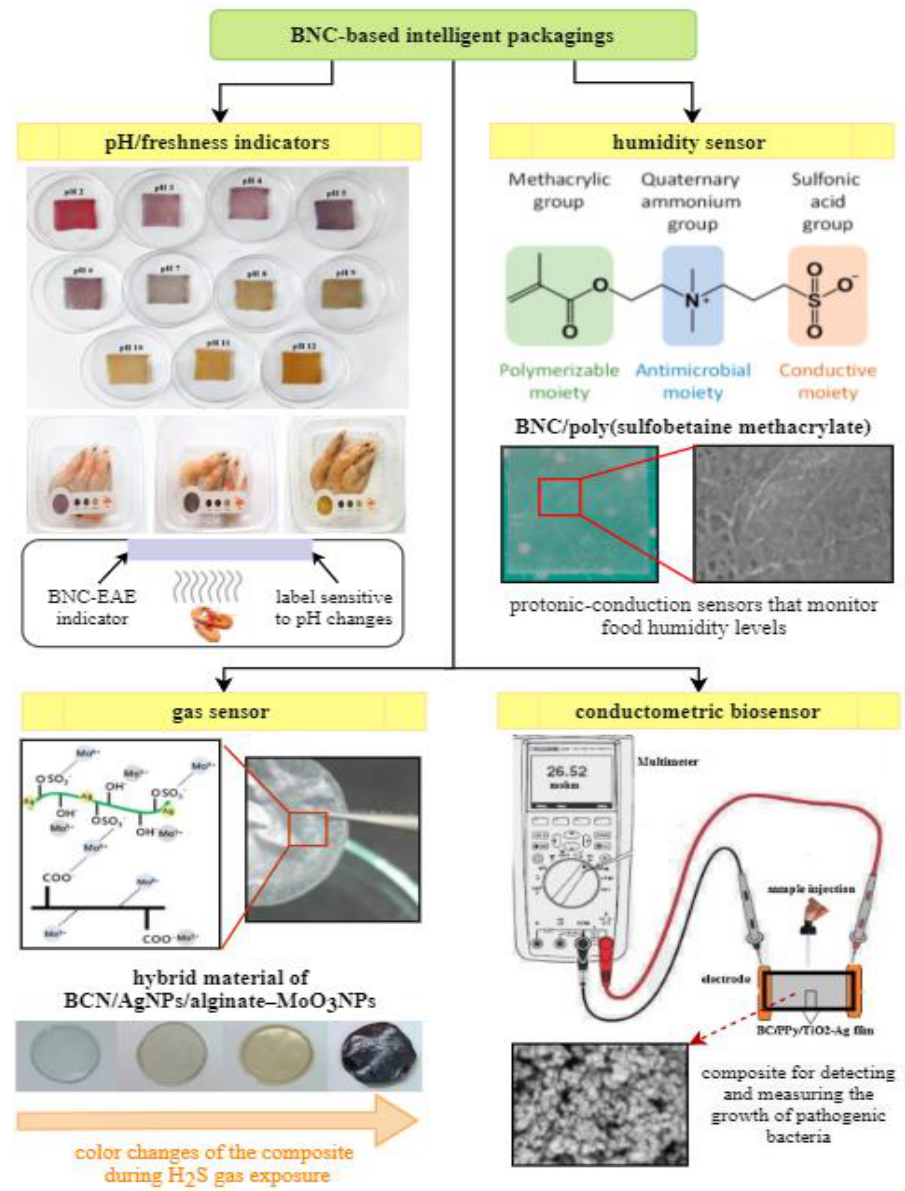
Figure 4. The main types of BNC-based intelligent packagings [98,119,122,123]. Table 2. The overview of BNC-based intelligent packagings and their effect on foodstuff.